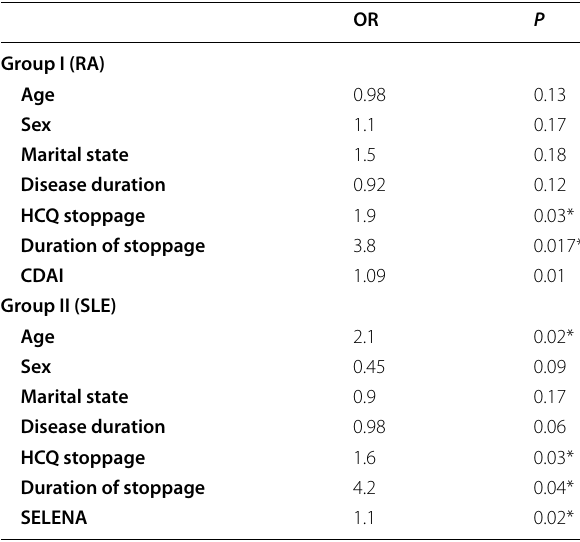
Table 6 Relation between anxiety “Hamilton Anxiety Rating Scale” and different